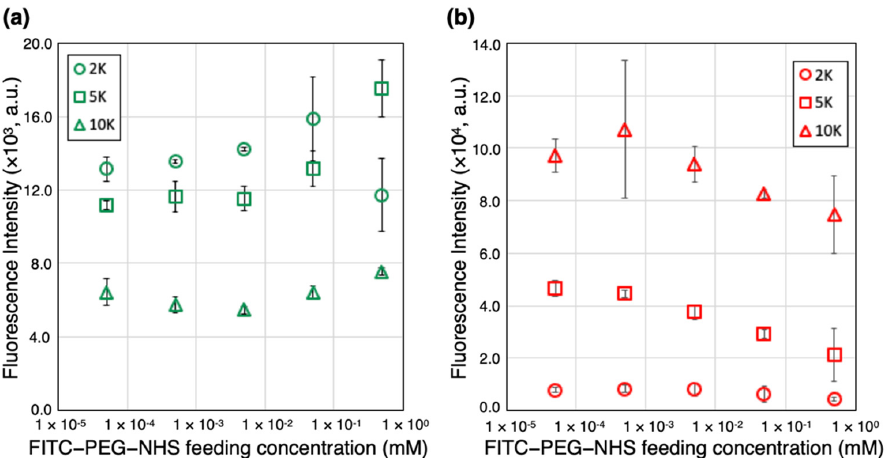
Figure 2. Fluorescence intensity of FITC-PEG 2k, 5k, 10k-Cy5-PC-Latex. ( a ) Fluorescence intensity of the FITC group conjugated on the terminus of PEG. ( b ) Fluorescence intensity of Cy5 used as model drug of the photo responsive platform.